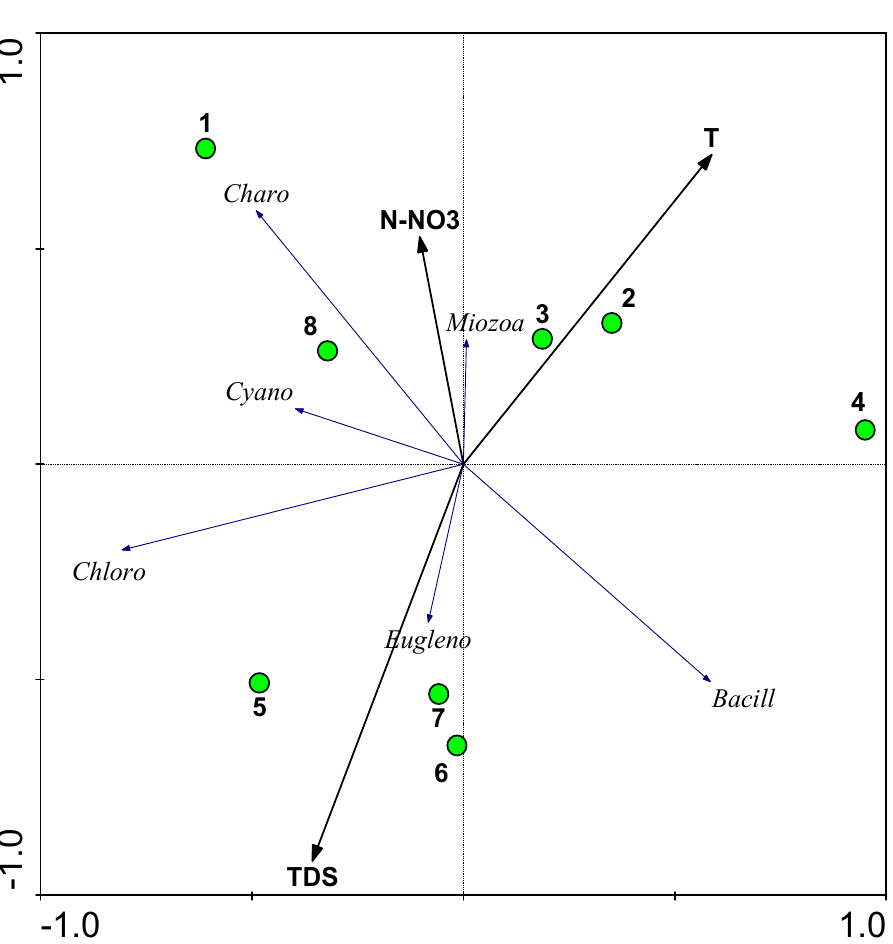
Figure 8. RDA plot of the relationships between environmental variables: temperature, nitrates- nitrogen concentration, TDS, depth, and species richness in phyla of phytoplankton in the Lake Borovoe, 2019. Monte Carlo test summary for 945 permutations: eigenvalue = 0.421; p -value = 0.136.